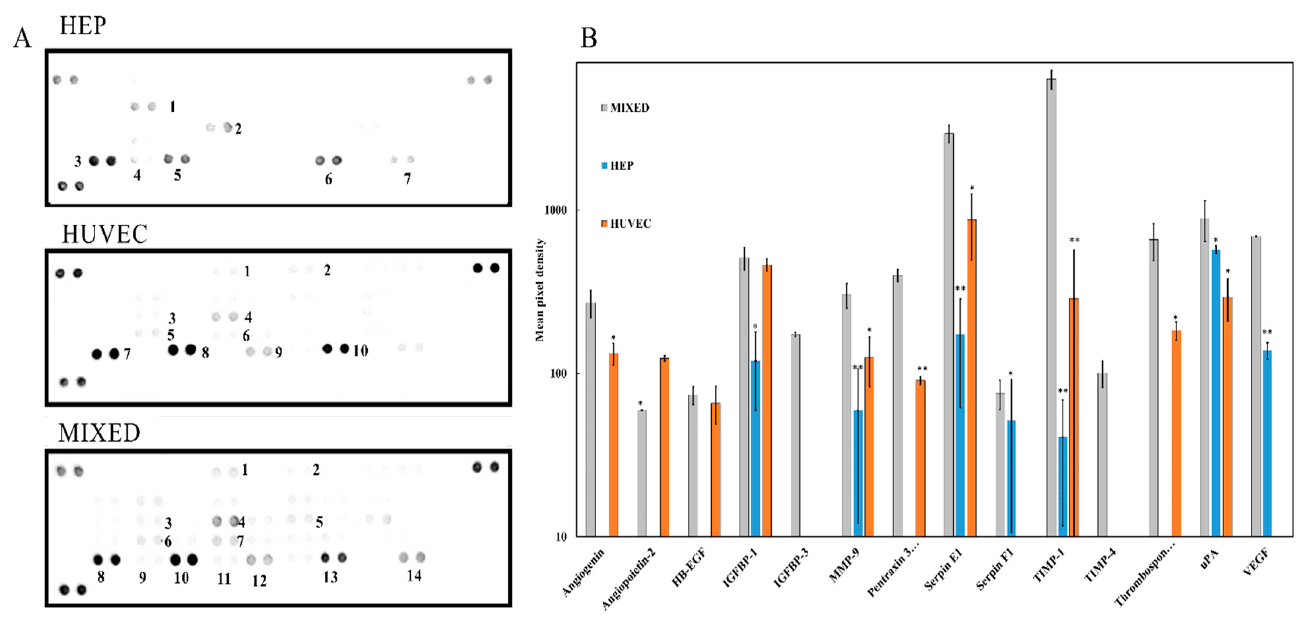
Figure 6. ( A ) Angiogenesis array membrane of individual Hep-G2 clusteroids, HUVEC clusteroids, and the co-culture Hep-G2 and HUVEC clusteroids at a Hep-G2 to HUVEC cell ratio of 5:1 after 21 days of proliferation in the Matrigel. The initial total cell number was 1 × 10 6 mL − 1 . ( B ) Angiogenesis-related protein production in the individual Hep-G2 clusteroids, HUVEC clusteroids, and the co-culture Hep-G2 and HUVEC clusteroids. Data were plotted as mean ± standard deviation of at least three independent experiments. Statistically significant differences between each region are denoted by * ( p < 0.05) or ** ( p < 0.01).